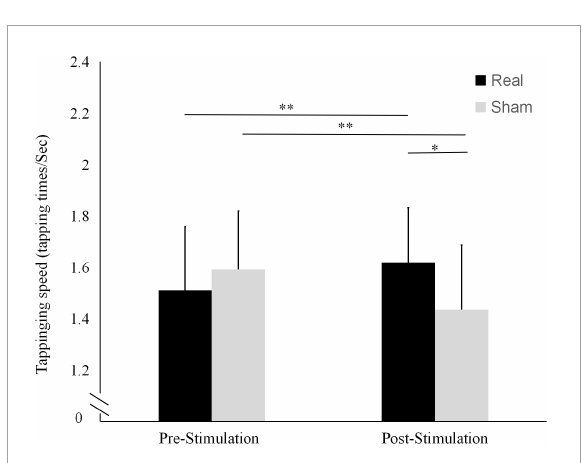
FIGURE4 Differences in tapping frequencies before and after the real and sham stimulation sessions. ** P < 0.01, * P <